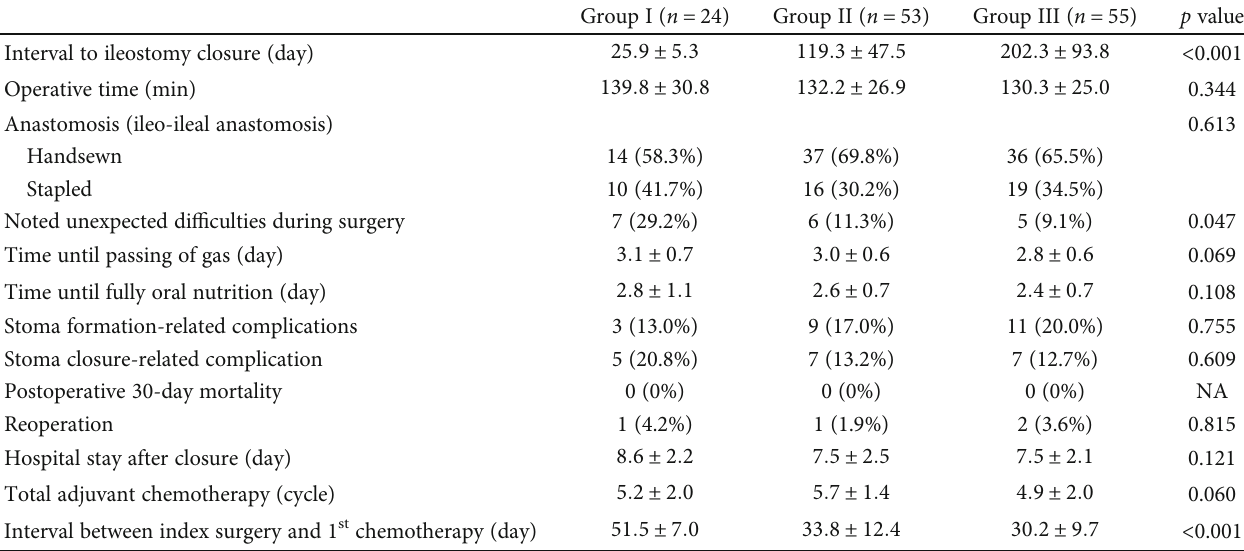
Table 2: Details of loop ileostomy closure.